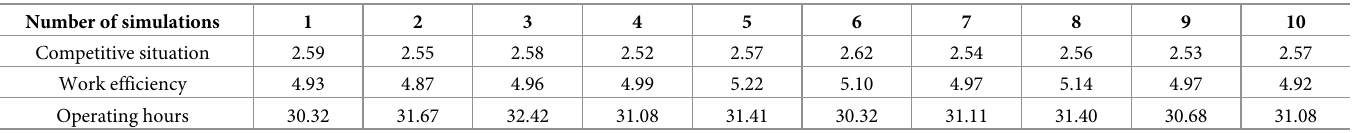
Table 3. Comparison of simulation results under actual conditions.